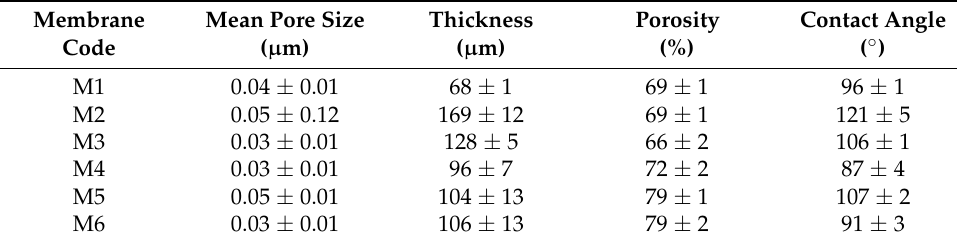
Table 4. Mean pore size, thickness, porosity and contact angle of the M1–M6 membranes.